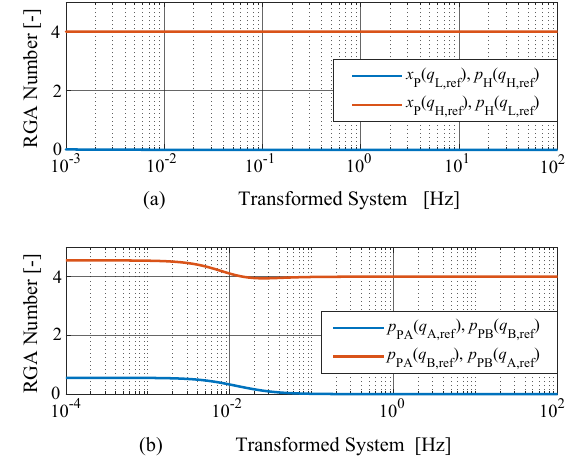
Figure 11: (a) RGA-numbers for the transformed sys- tem in motion operating mode. (b) RGA- numbers for the system operated in load holding